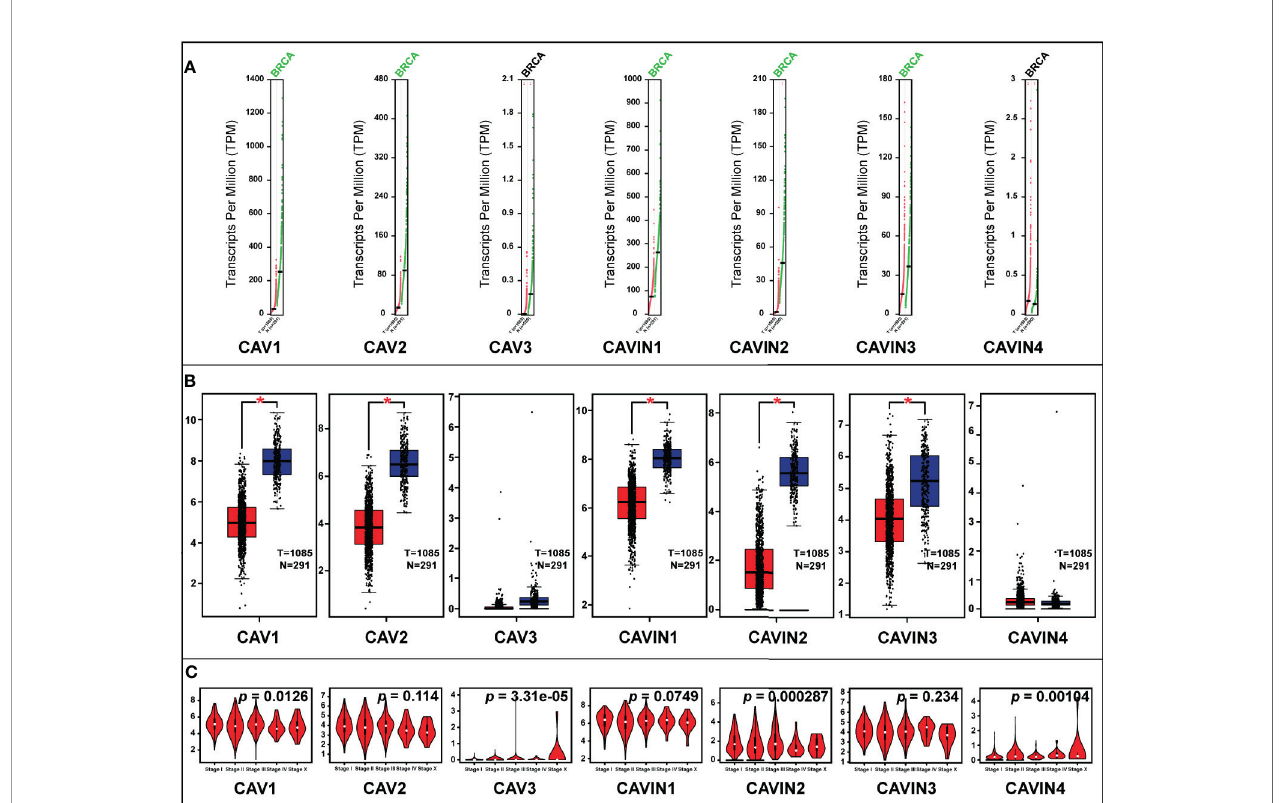
FIGURE 2 | (A) Scatter diagram of expressions of CAVs and CAVINs in breast cancer. (B) Box plot of expression of CAVs and CAVINs in breast cancer (* p < 0.05). (C) Correlation between CAVs and CAVINs levels and clinical stages of patients with breast